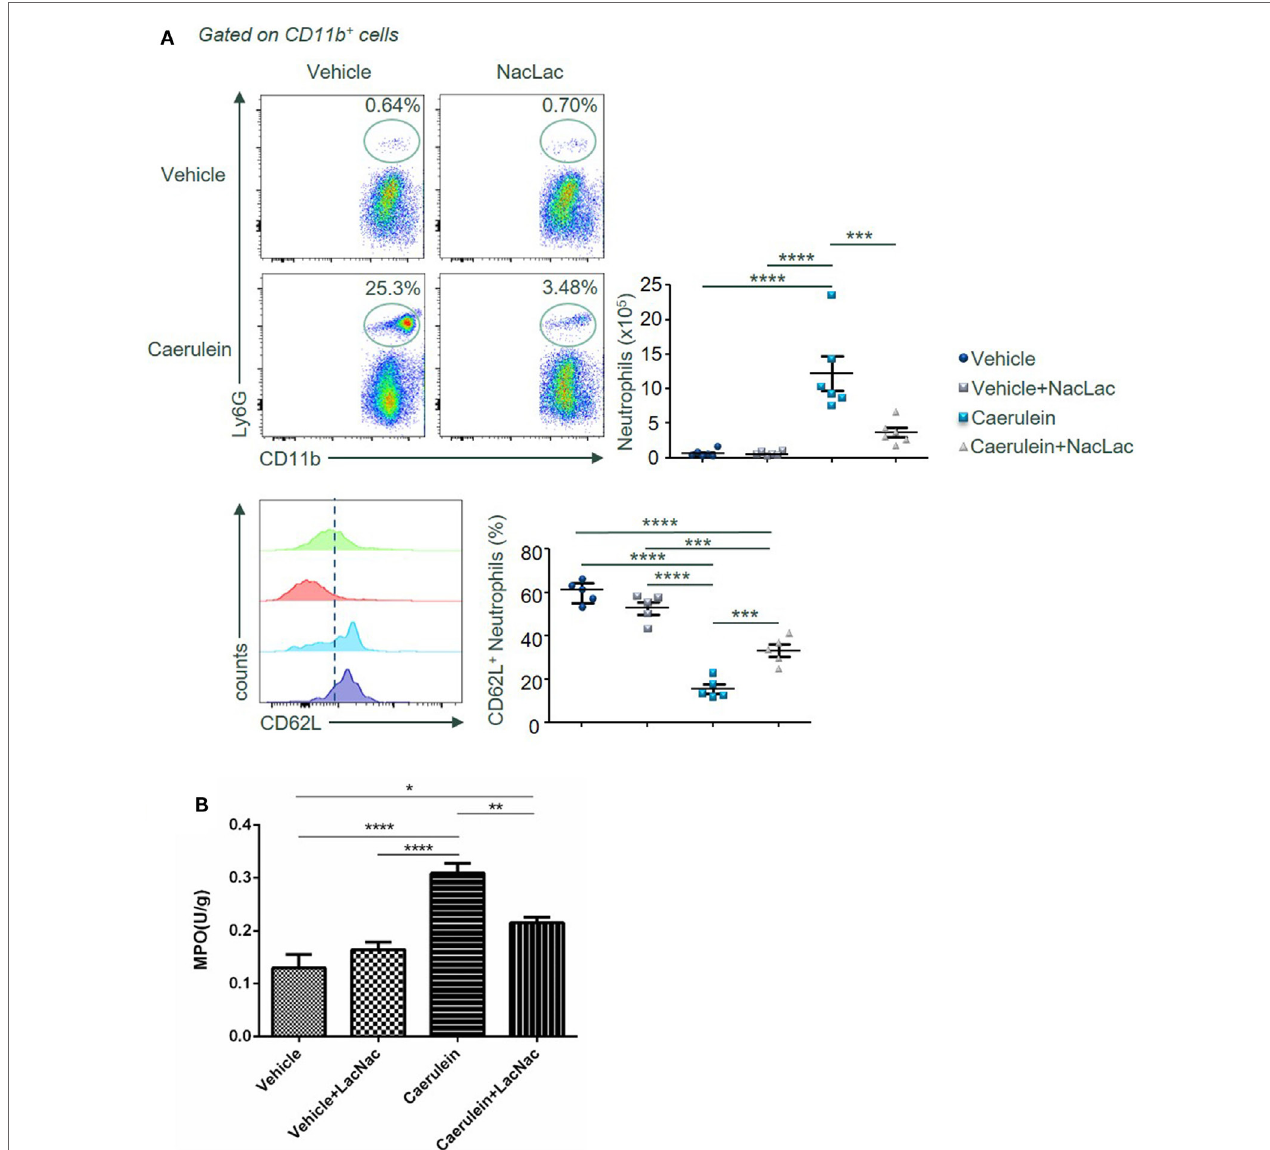
FigUre 6 | An antagonist of galectin-3 mimicking lactose suppresses neutrophil recruitment and activation in the pancreas after AP induction. Female BALB/c mice were treated with caerulein together with or without N -acetyl- d -lactosamine and 3 h later cells were recovered from the pancreas. (a) The frequency of CD62L + neutrophils in the pancreas was shown. Results are representative or median values ± interquartile range from three independent experiments with a minimum of five to six independent mice. (B) Pancreatic myeloperoxidase activities were shown. Results are mean ± SEM from two independent experiments of at least five independent mice in each group. * p < 0.01, ** p < 0.01, *** p < 0.001, **** p < 0.0001 by one-way analysis of